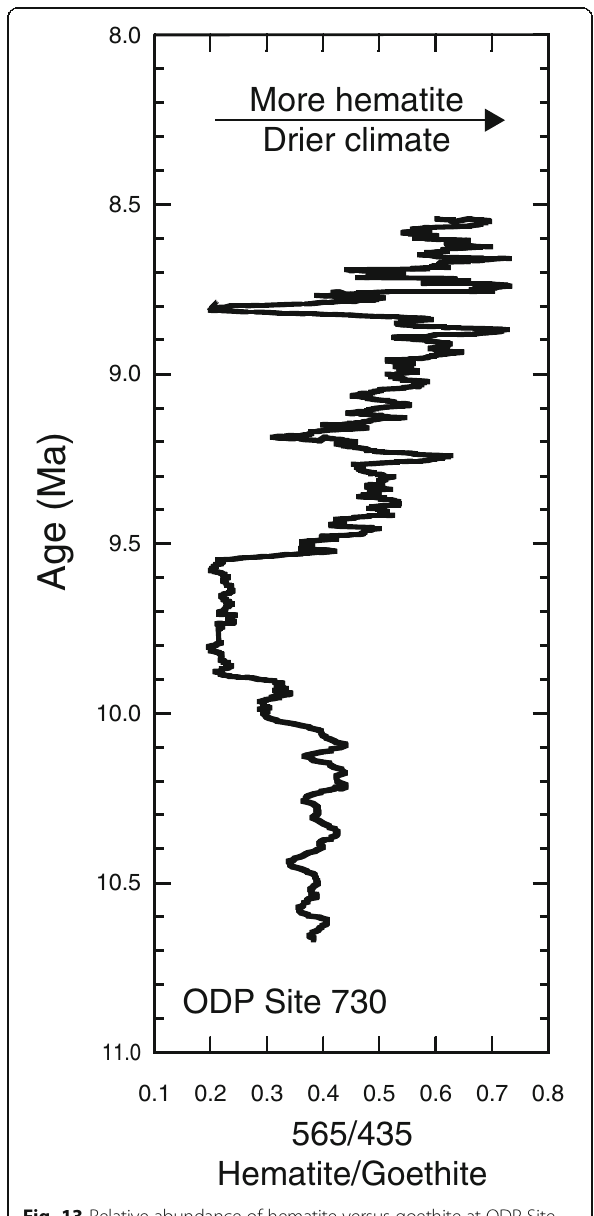
Fig. 13 Relative abundance of hematite versus goethite at ODP Site 730 on the Oman margin implies steady drying after 9.5 Ma following a wet period from 9.9 to 9.5 Ma. See Fig. 2 for